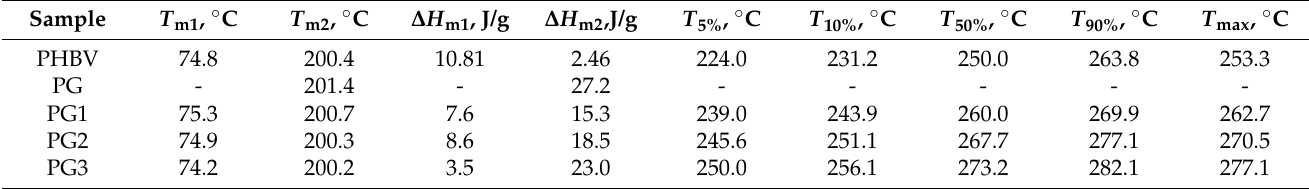
Table 2. DSC and TGA/DTGA (derivative thermogravimetric analysis) results of the PHBV, pure PG and film